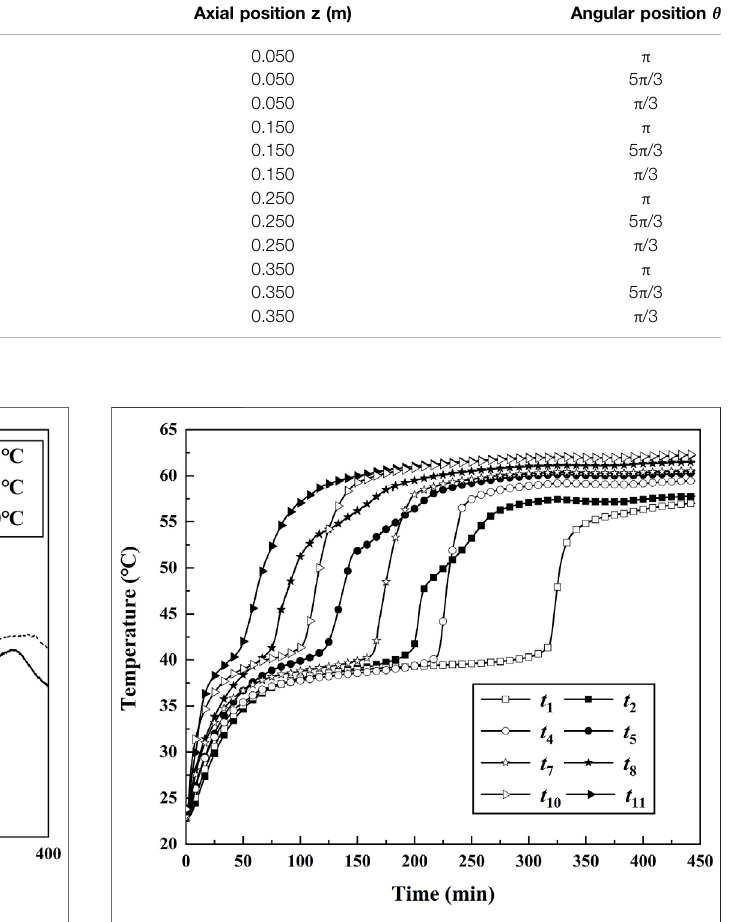
FIGURE 3 | Timewise variation of an averaged temperature difference between fi rst and repeated experiments.